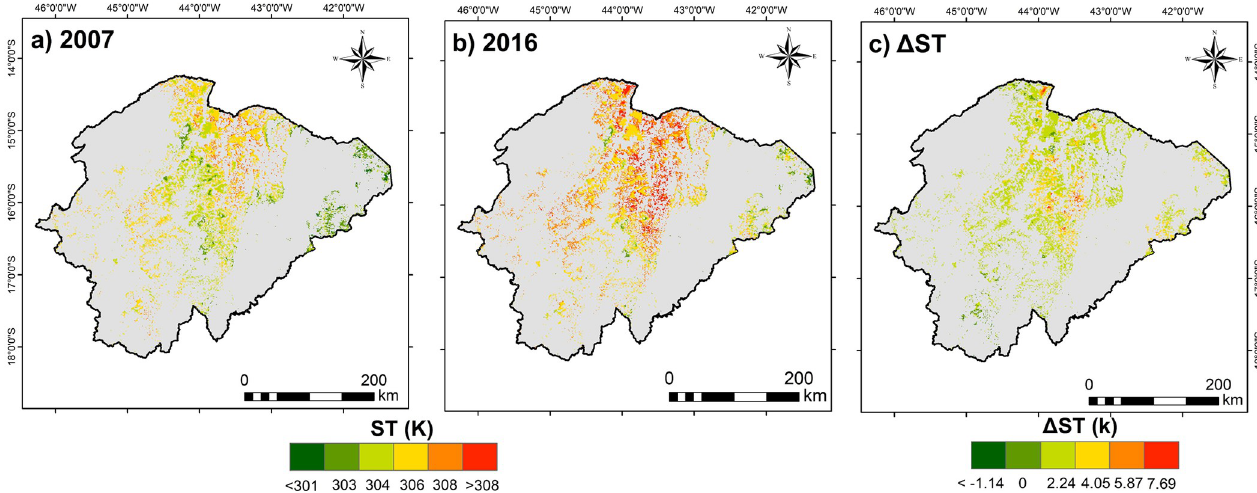
Fig 3. Spatial distribution of surface temperature (ST) in the TDFs domain. a) Spatial distribution of ST for 2007; b) Spatial distribution of ST for 2016; c) Difference ( Δ ST) between the ST for the years 2016 and 2007 ( Δ ST =